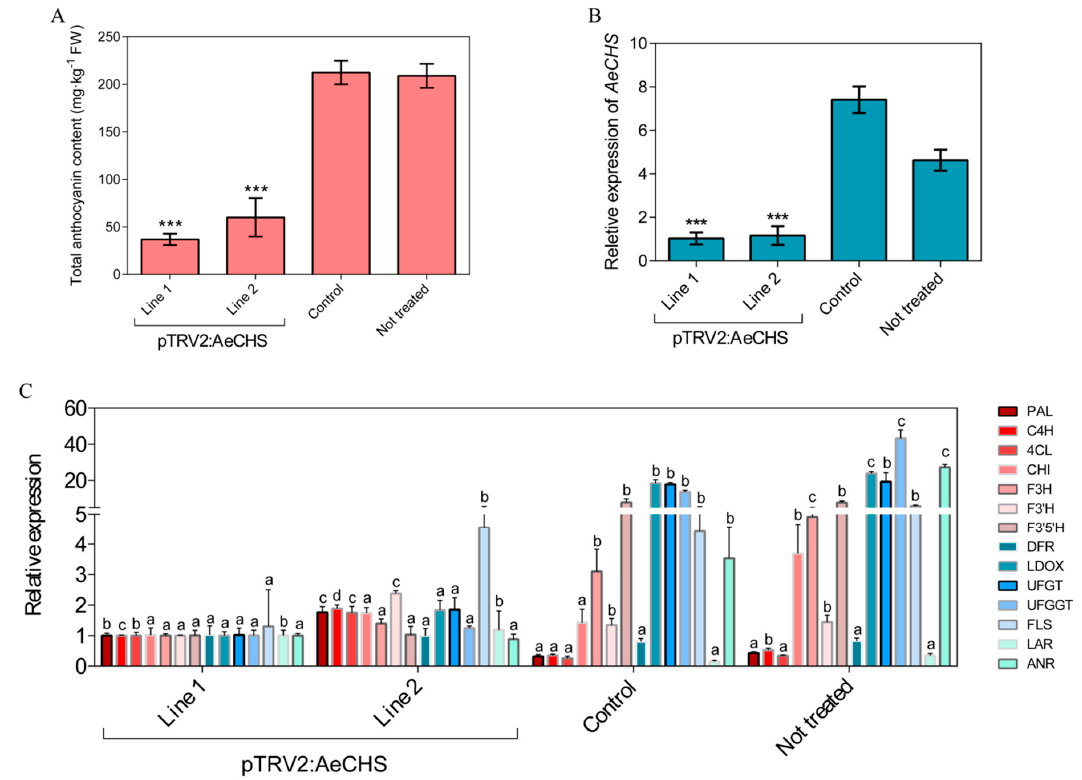
Figure 8. Total anthocyanin content and expression level of AeCHS and other genes involved in anthocyanin biosynthesis for VIGS samples. ( A ) Total anthocyanin analyses in silenced lines 1 and 2, control and untreated petal samples. ( B ) Expression profiles of AeCHS in silenced lines 1 and 2, control and untreated petal samples. Data are means ± SE of three replicates. Asterisks indicate significant di ff erences calculated using Duncan’s test (*** P ≤ 0.001). ( C ) Expression level of related genes involved in anthocyanin biosynthesis in silenced lines 1 and 2, control and untreated petal samples. Di ff erent letters denote statistical significance using one-way ANOVA, P < 0.05.